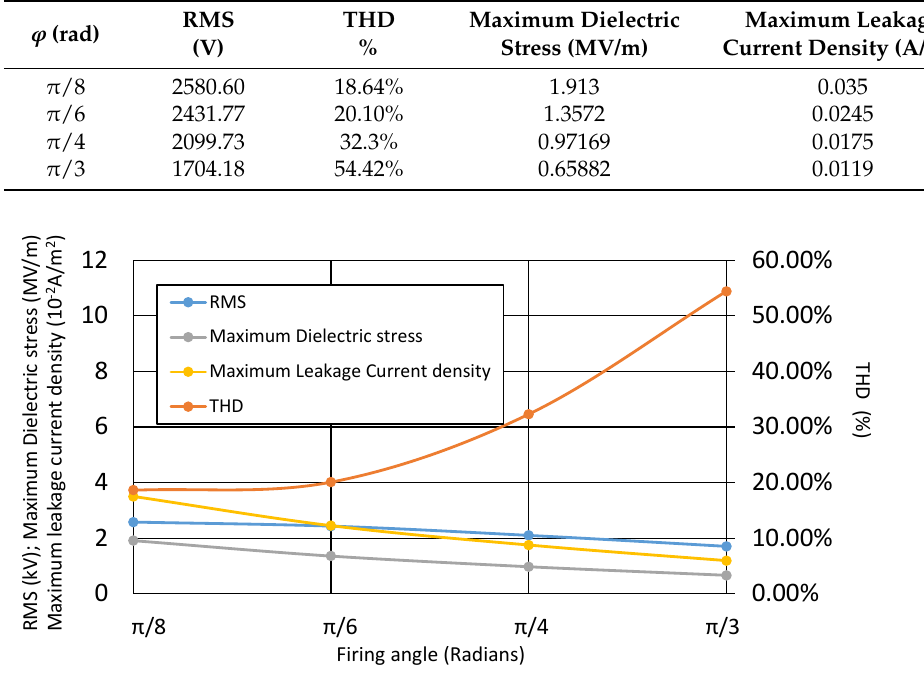
Figure 11. Effect of increasing firing angle in a 3-level inverter. Left Vertical axis: RMS in kV; Maximum Dielectric stress in MV/m; Maximum leakage current density in 10 − 2 A/m 2 ; Right Vertical axis: THD in %. Table 5. Effect of increase in firing angles for 3-level inverter output.